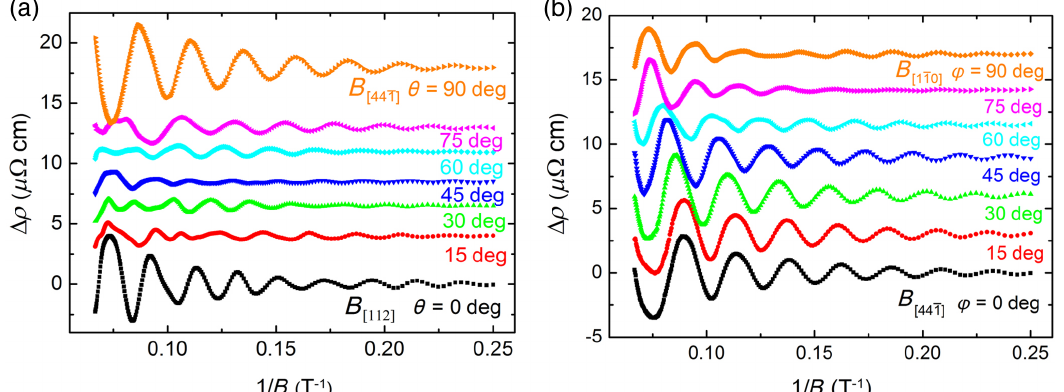
FIG. 4. Angular dependence of SdH oscillations at different magnetic field directions (sample 2). (a) SdH oscillations in Δ ρ for various magnetic field angles from B ½ 112 (cid:2) ( θ ¼ 0 deg, B in the [112] direction) to B ½ 44¯ 1 (cid:2) ( θ ¼ 90 deg, B in the ½ oscillations rotate from B ½ 44¯ 1 (cid:2) ( φ ¼ 0 deg, B in the ½ the definition of θ and φ